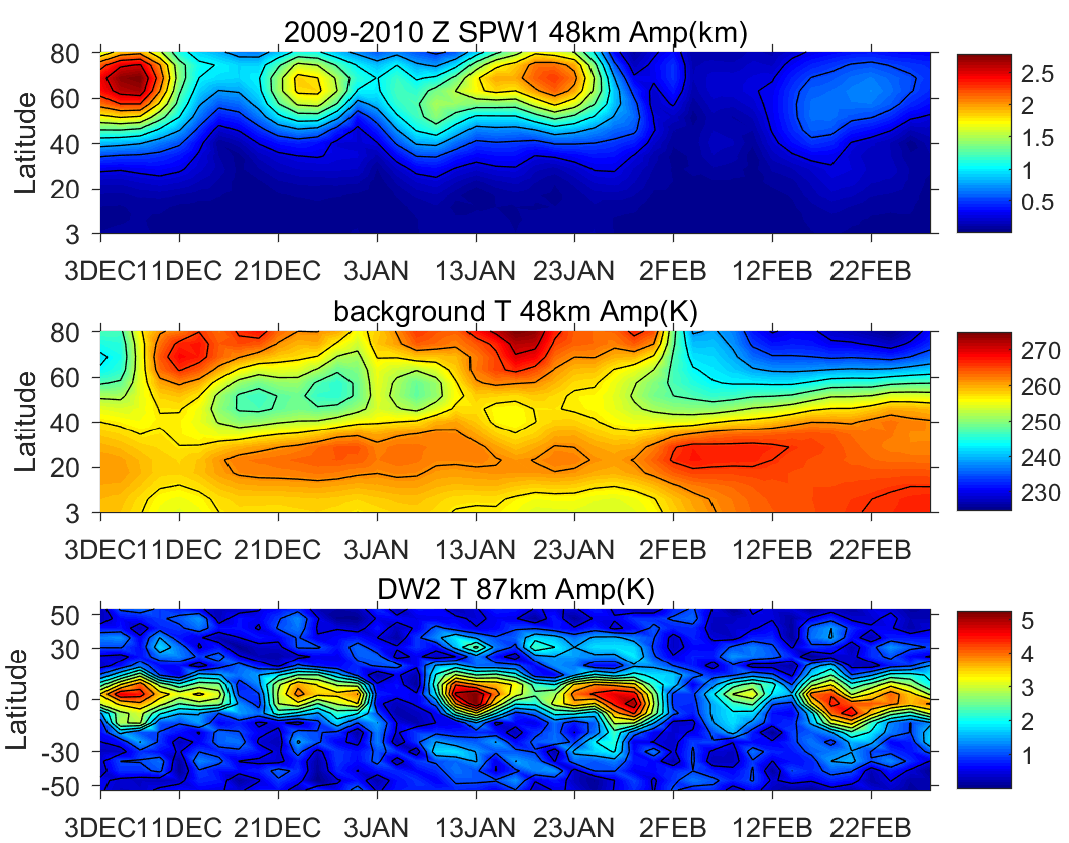
Figure 1. Same as Figure 8 in Leiberman et al. (2015) [8]. Latitude versus time variations in the eCMAM (extended Canadian Middle Atmosphere Model) parameters during December 2009–February 2010. (First panel) SPW1 (wavenumber 1) geopotential height (Z) amplitude at ~48 km, in kilometer. (Second panel) background temperature field (T). (Third panel) eCMAM DW2 (nonmigrating diurnal tide) temperature amplitude at ~87 km.